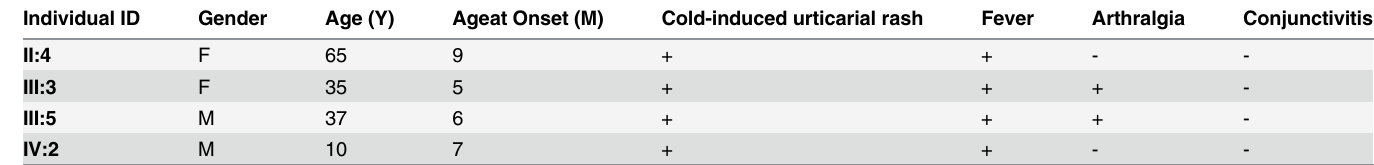
Table 1. Clinical Summary of the Individuals in this Study. M, Male; F, Female; +, Affected; -, Not affected. Individual